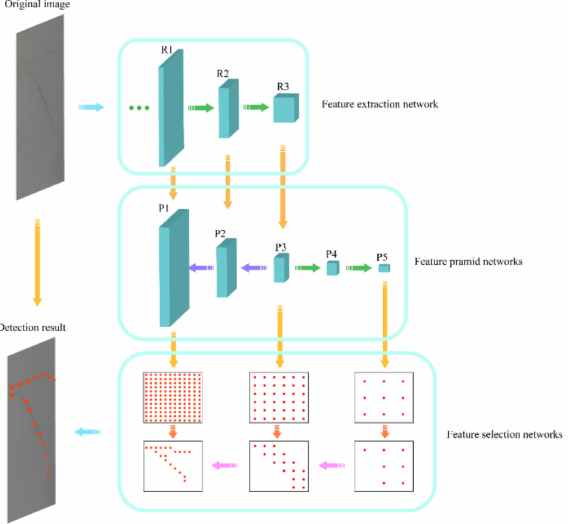
Figure 6. Model network